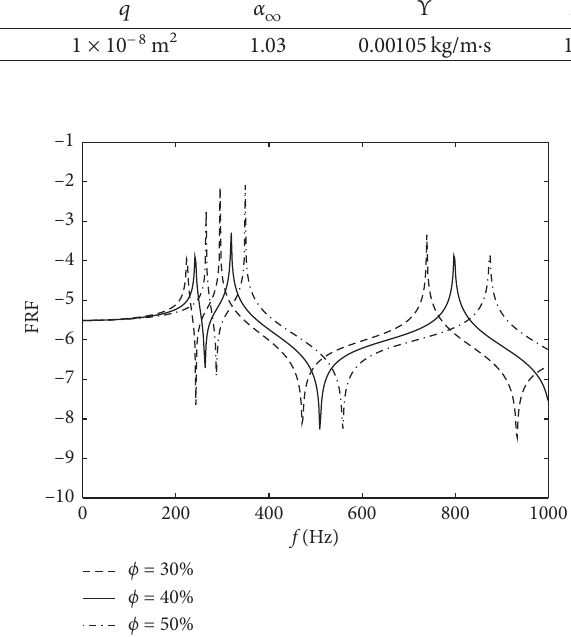
Figure 5: FRF curve for various